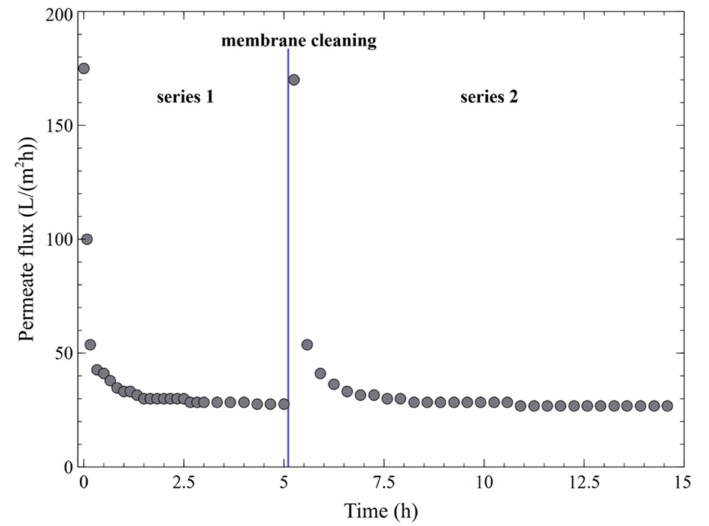
Figure 6. Changes in the permeate flux during the UF process of a fermentation broth (pH = 7). The blue line represents cleaning of the membrane module with 1% NaOH solution (15